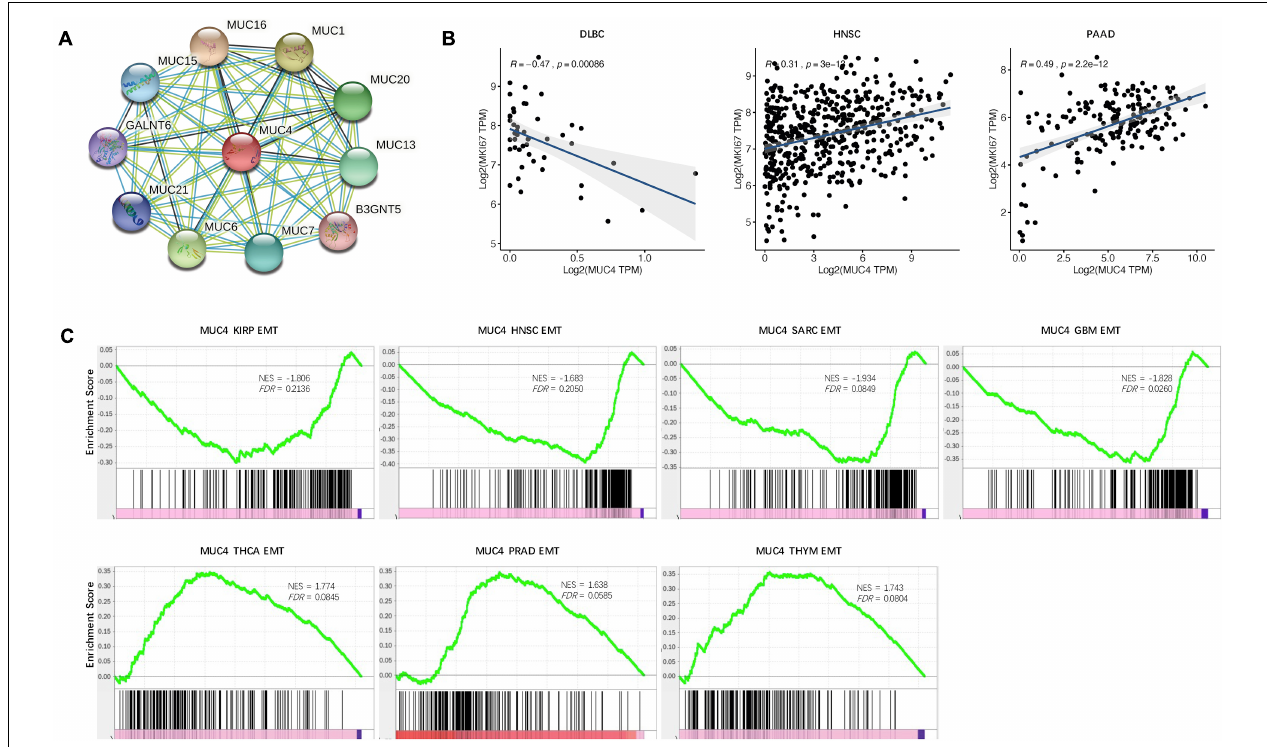
FIGURE 4 | Functional effects of MUC4 . (A) PPI network. Network nodes represent proteins and edges represent protein–protein associations, including both functional and physical protein associations. Line thickness indicates the strength of data support. (B) Correlation of MUC4 with proliferation in CVCDAP. (C) Enrichment of MUC4 in EMT in CVCDAP. Values of NES denote positive and negative enrichment. EMT, epithelial–mesenchymal transition.